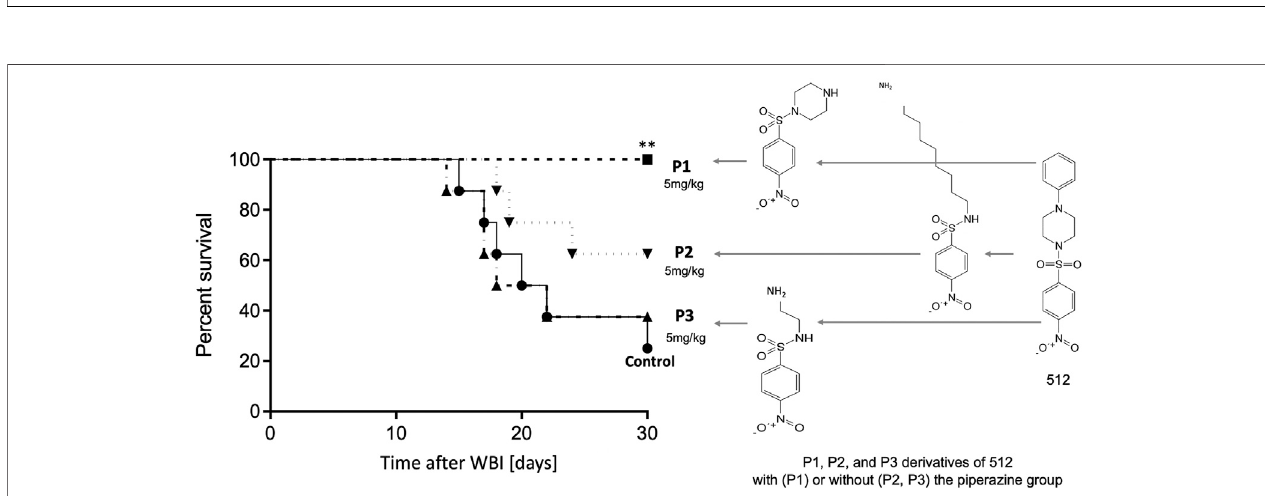
FIGURE 2 | The piperazine group is essential for ef fi cacy of 512 at 5 mg/kg, but can be modi fi ed without loss of activity, P1 being able to fully mitigate H-ARS ( p (cid:2) 0.0085) whereas P2 and P3 analogs without piperazine lost activity.